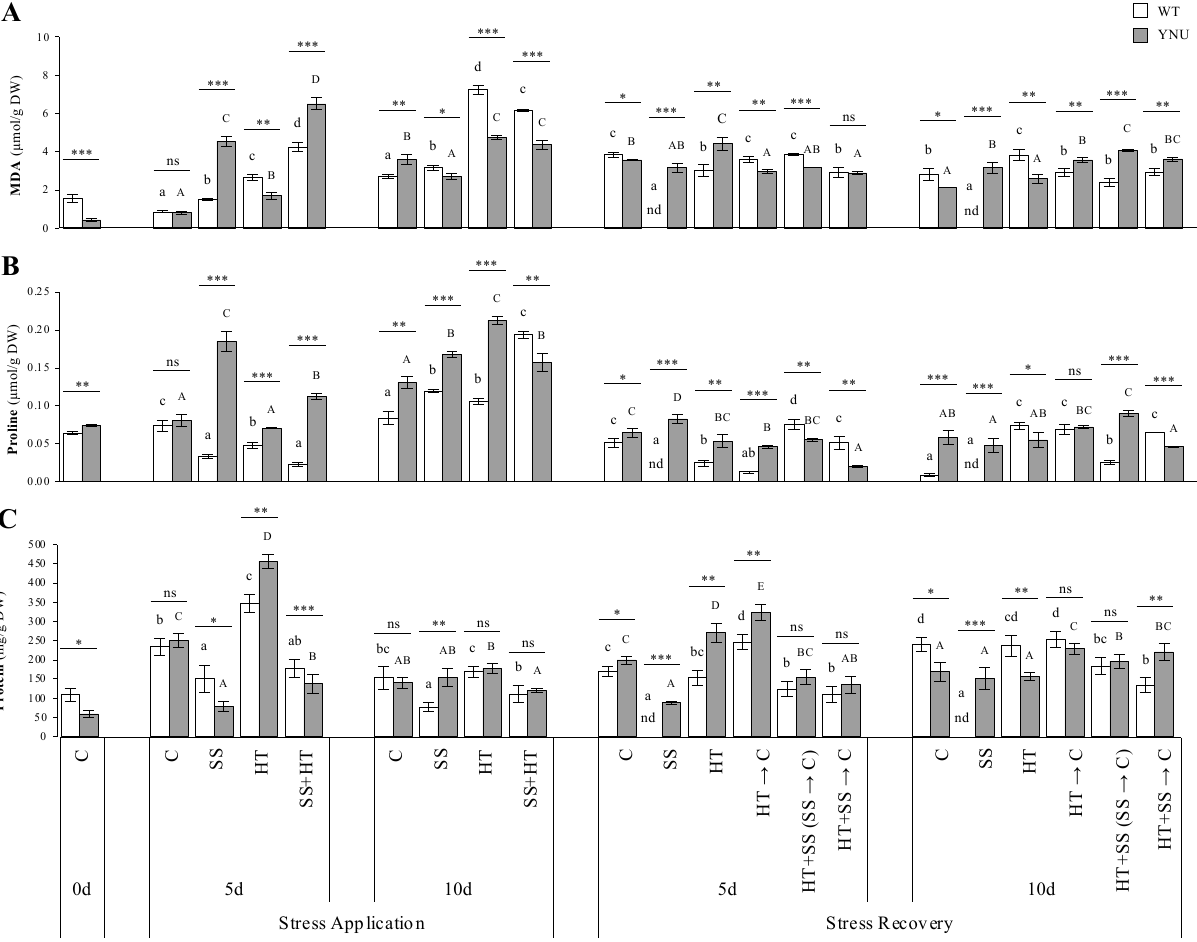
Figure 4. Biochemical responses to salinity (SS), high-temperature (HT), and combined salinity and heat (SS + HT) of rice seedlings; ( A ) Malondialdehyde (MDA), ( B ) proline, and ( C ) protein of WT and YNU plants under control (C: 26/23 °C, 0 mM NaCl), salt stress (SS: 26/23 °C, 75 mM NaCl), high-temperature (HT: 30/26 °C, 0 mM NaCl), and combined salinity and heat (SS + HT: 30/26 °C, 75 mM NaCl) conditions. Values represent the means ± SE determined from three independent experiments using four plants in each experiment. Means within the same graph followed by different lowercase (WT) and uppercase (YNU) letters are significantly different at p < 0.05 according to Tukey’s HSD test. Asterisks represent statistical significance of difference using Student’s t -statistic with *** p < 0.001, ** p < 0.01, * p < 0.05, ns: non-significant. nd: not determined. Under HT conditions, only the catalase (CAT) enzyme had a similar or decreased activity with respect to C plants during stress (Figure 5A). The coupled stress induced the synthesis of superoxide dismutase (SOD) in both cultivars after short-term exposure (Fig- ure 5B). In contrast, the single stresses did not change SOD activity in the two phases of the stress occurrence in WT and DAT10 in YNU (Figure 5B). As for ascorbate peroxidase (APX), except for the increase in YNU under SS and/or the HT treatments at DAT5, the different stress treatments and post-stress recovery resulted in a similar pattern through- out the experiment (Figure 5C). For prolonged periods after stress-release, DAT15 and 20, YNU maintained higher protein content and CAT activity and similar proline, while WT leaf proline levels were continuously higher than in the C condition (Figures 4 and 5).